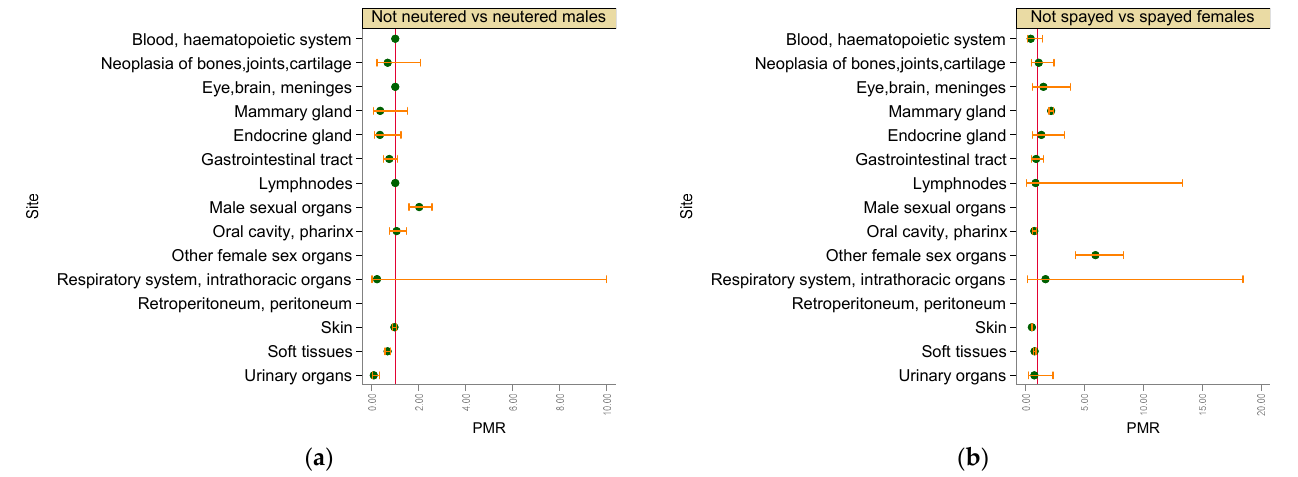
Figure A3. Proportional morbidity ratios (PMR) of benign tumour by topography: ( a ) not neutered males vs. neutered males, ( b ) not spayed females vs. spayed females. Dots: age-class-adjusted PMR; bars: lower and upper bound of 95% confidence interval. A vertical reference line indicates PMR = 1.